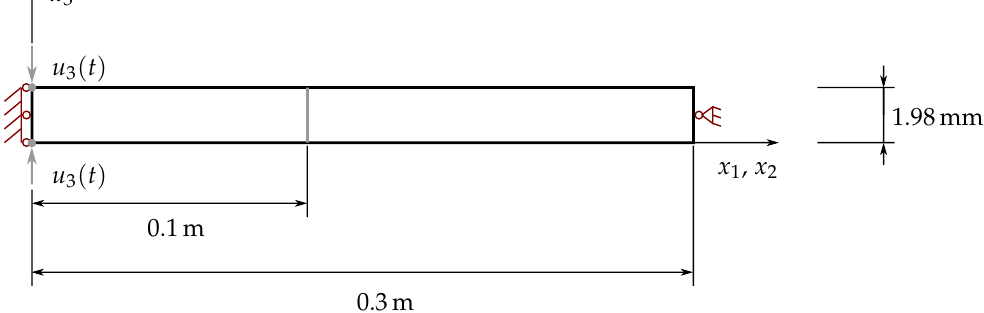
Figure 5. Numerical 2D model for the computation of the displacement fields including the boundary conditions.